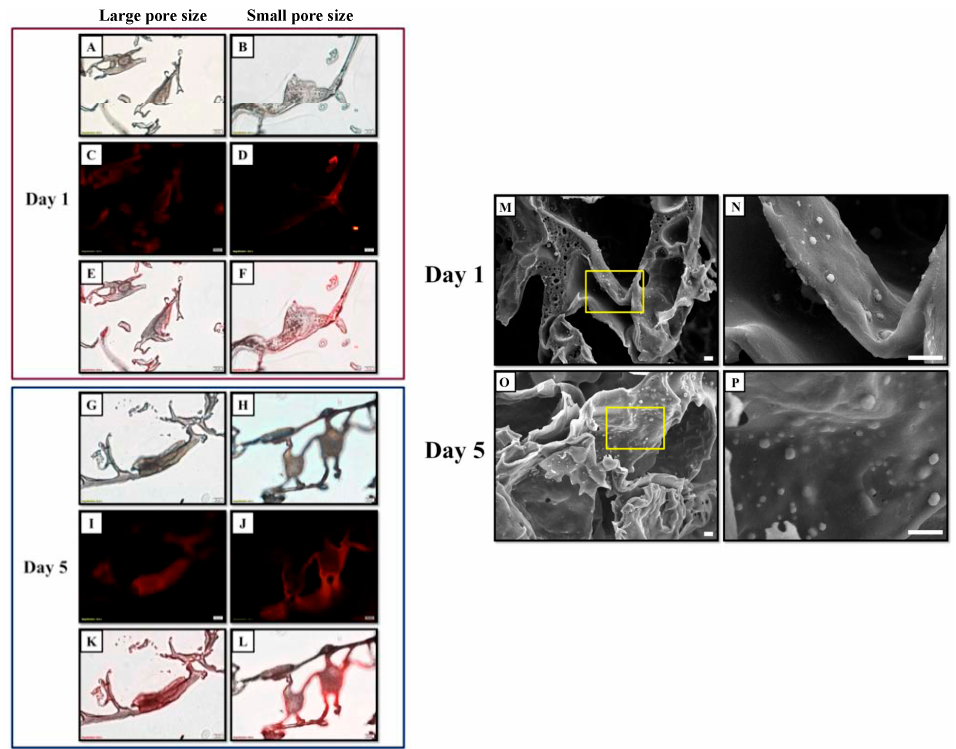
Figure 2. Images of chondrocytes on PLGA scaffolds with different pores sizes after one and five days of culture. The cell membrane was labeled with red fluorescent dye. ( A,B,G,H ) Light micrographs. ( C,D,I,J ) Fluorescence micrographs. ( E,F,K,L ) Merged light and fluorescence micrographs. The red and blue boxes indicate the images of cells on PLGA scaffolds at day one and five, respectively. Scale bar: 20 μ m. ( M–P ) SEM images of cell-seeded PLGA scaffold with a small pore size: images of cells cultured on PLGA scaffolds on day one ( M,N ) and day five ( O,P ). The area enclosed by the yellow box is shown enlarged to the right. Scale bar: 10 μ m.